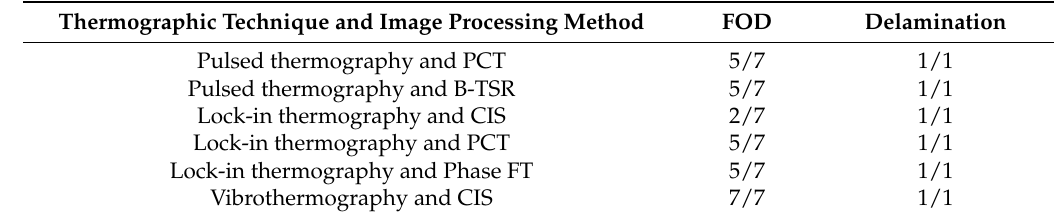
Table 4. Performance of thermographic methods.